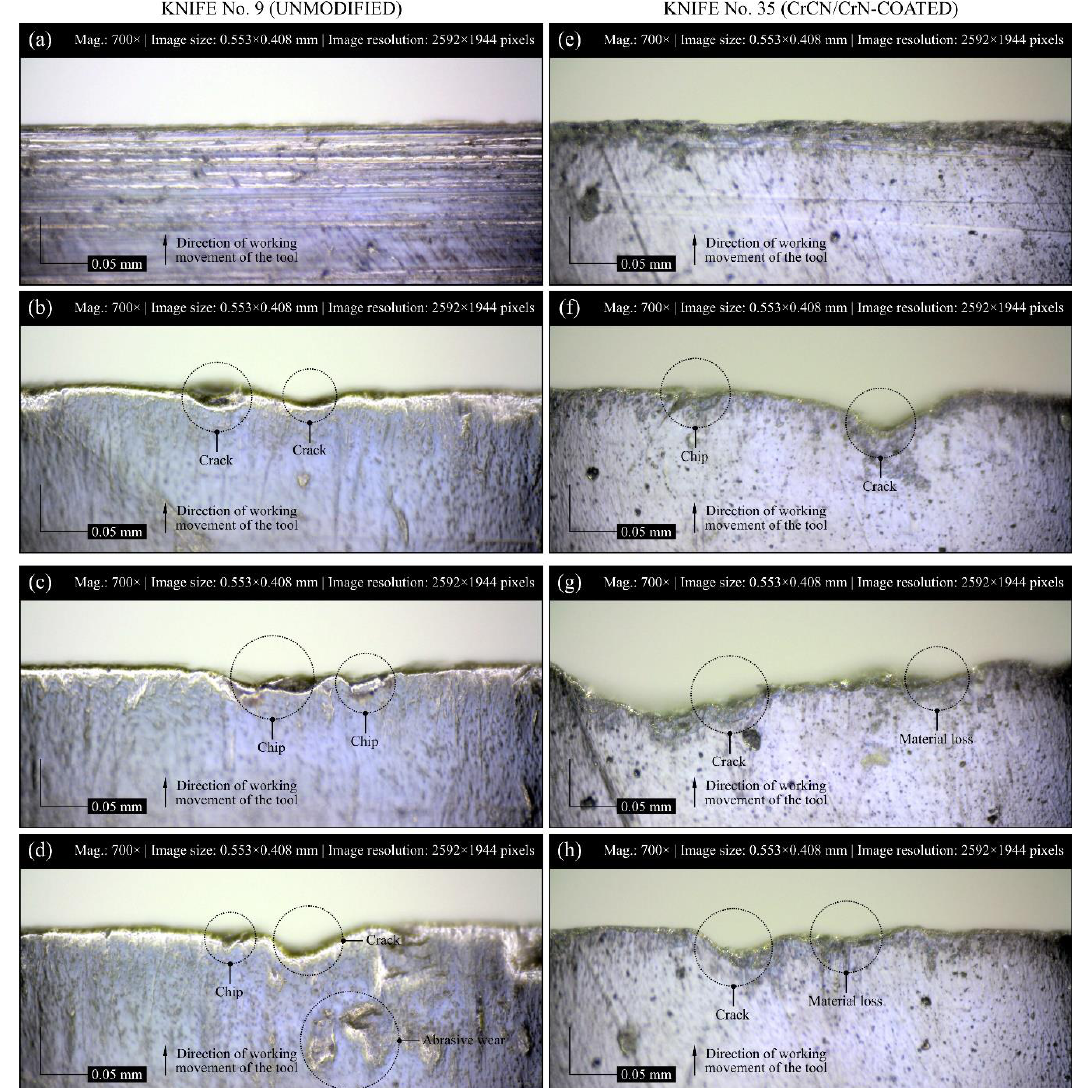
Figure 13. Selected results of digital images acquired of the rake face of industrial planer knives: ( a ) surface of unmodified knife No. 9 (Set 1, Head U1) (reference), ( b – d ) with various visible forms of surface wear; ( e ) modified knife No. 35 (Set 1, Head L1) (reference), ( f – h ) with visible wear of the surface.